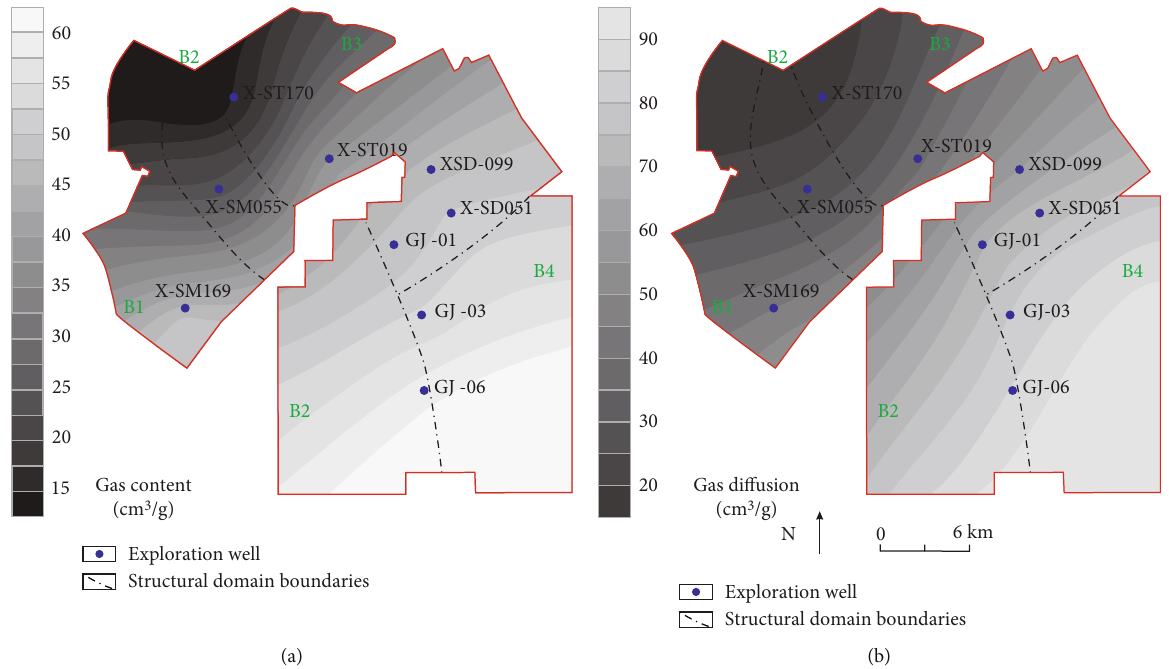
Figure 11: Distribution characteristics of gas content (a) at the end of Early Jurassic period and gas di ff usion during the Early Yanshanian orogeny (b).